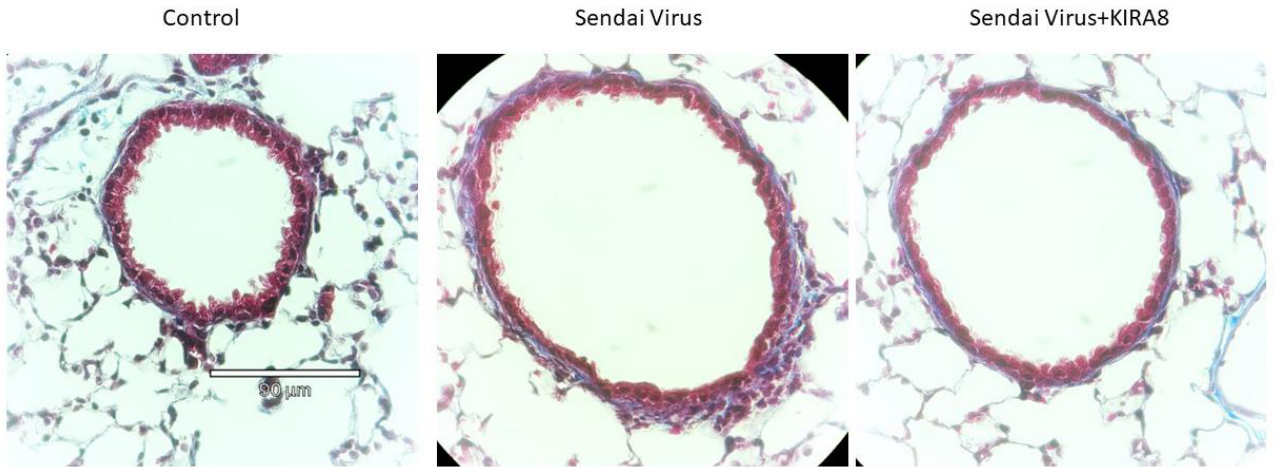
Figure 5. Histological analysis of IRE1 α signaling in SeV infection. Masson’s trichrome staining was performed on paraffin-embedded sections from uninfected, SeV infected, or SeV+KIRA8 treated animals. Shown is a small airway. Images were taken at 40 X; scalebar indicates 90 µm. Note the subepithelial accumulation of cells (nuclei) and expansion of ECM (blue) in the SeV infected mice that was reduced by KIRA8.